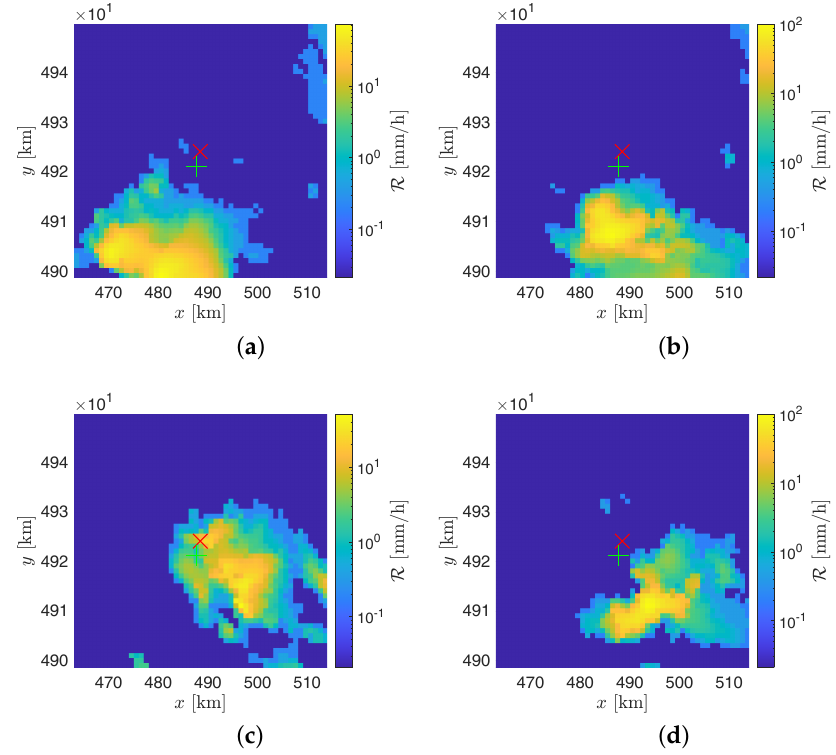
Figure 12. Precipitation maps provided by the GPM250C weather radar on the 14 August 2018 at ( a ) 8:00 UTC, ( b ) 8:50 UTC, ( c ) 9:50 UTC, and ( d ) 10:50 UTC. The red cross indicates the Monte Scarpino landfill, whereas the green plus sign indicates the RG at Monte